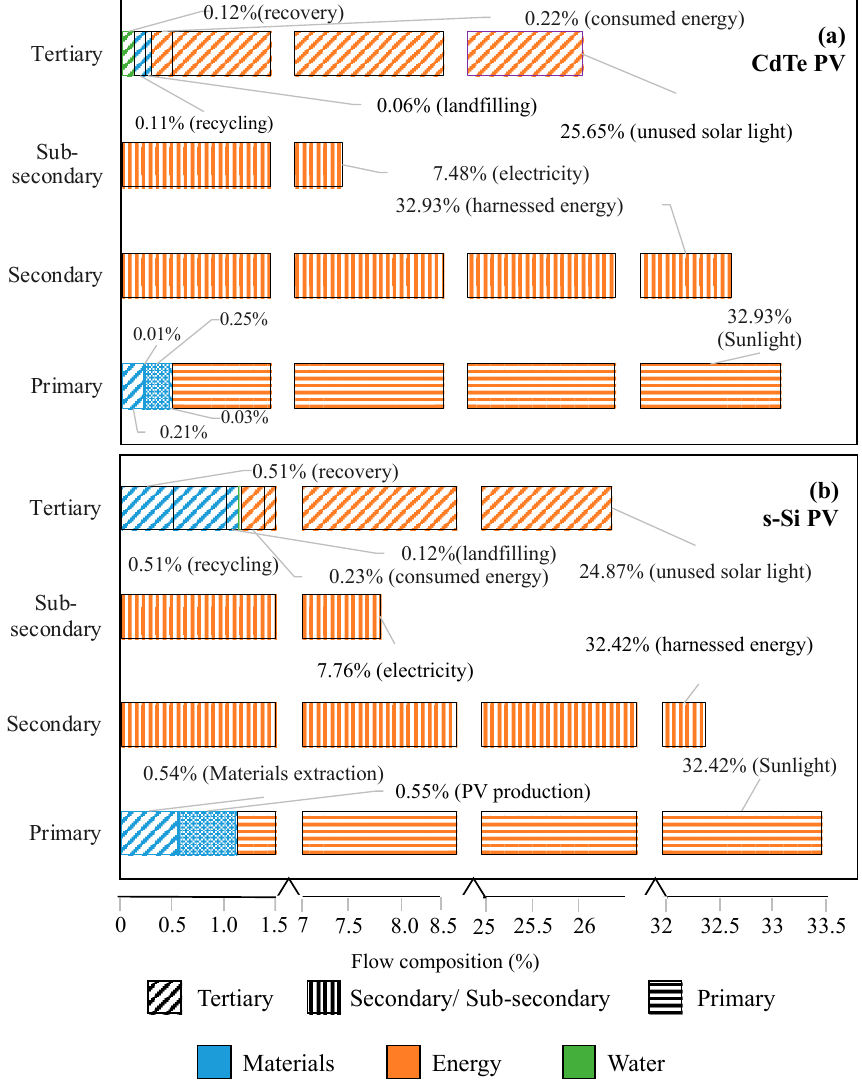
Figure 2. MEW flow of the CdTe ( a ) and s-Si ( b ) PV technology. The trophic characteristics are shown for their percentage of the total inflow in each industry.